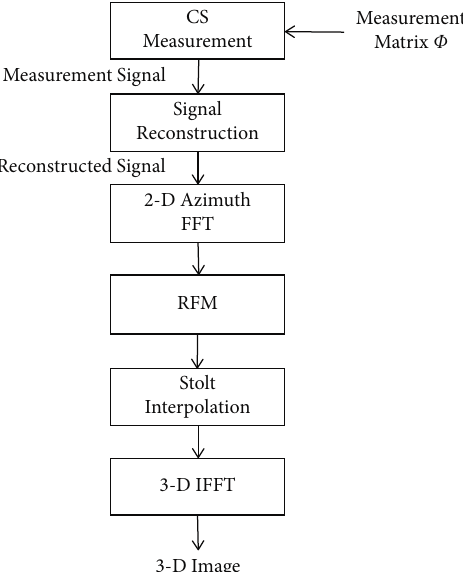
Figure 4: THz FMCW SAR imaging algorithm based on compressed sensing.